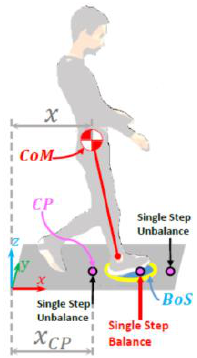
Figure 1. Single step balance and unbalance state.